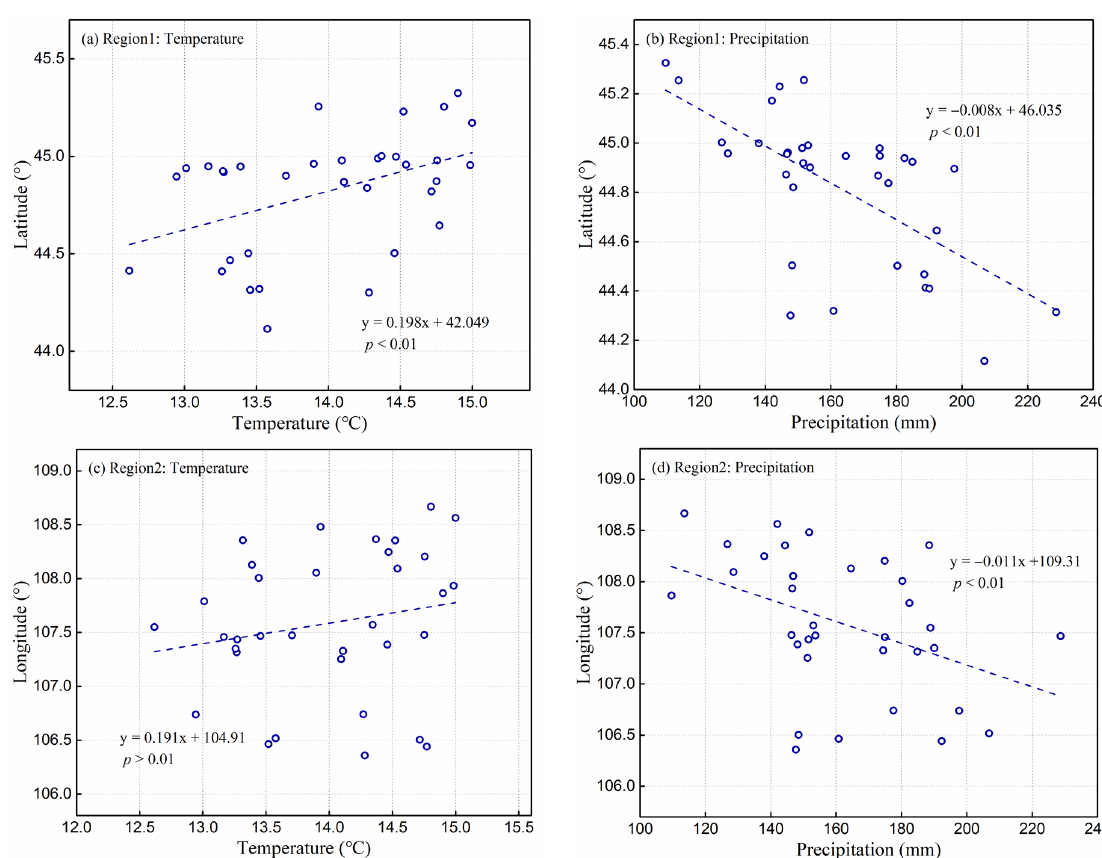
Figure 8. Regression relationship between the latitude ( a , b ) and longitude ( c , d ) of the vegetation greenness line with temperature and precipitation in the growing season, respectively.